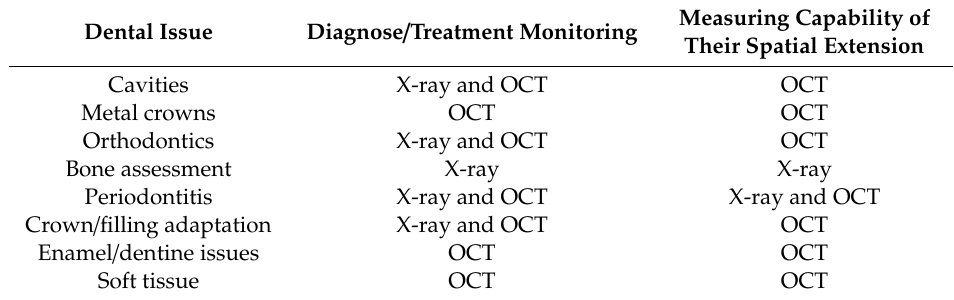
Table 4. Medical imaging technique suitable for diagnose / treatment checking and assessment of dental